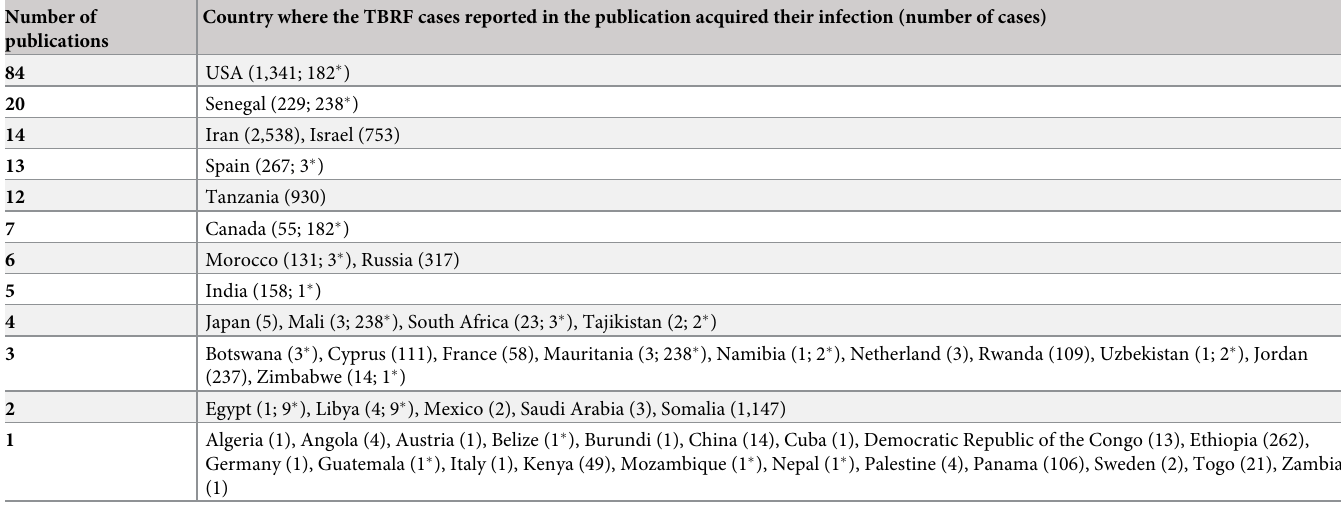
Table 4. Number of publications on TBRF cases by country where the infections were most likely acquired (n = 240 studies). Number of Country where the TBRF cases reported in the publication acquired their infection (number of publications